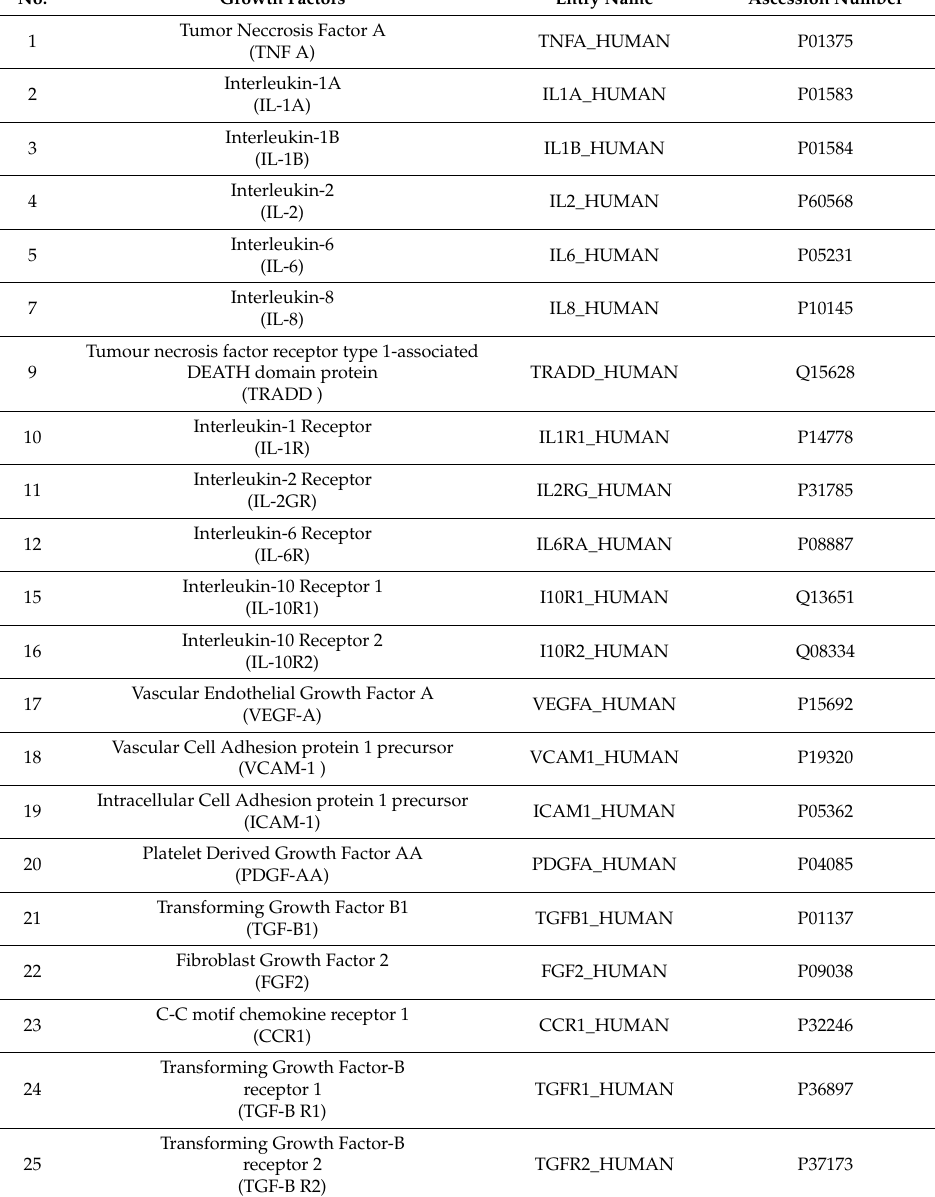
Table 3. List of protein identifications in adult peripheral blood (APB) and cord blood (CB) PRP.